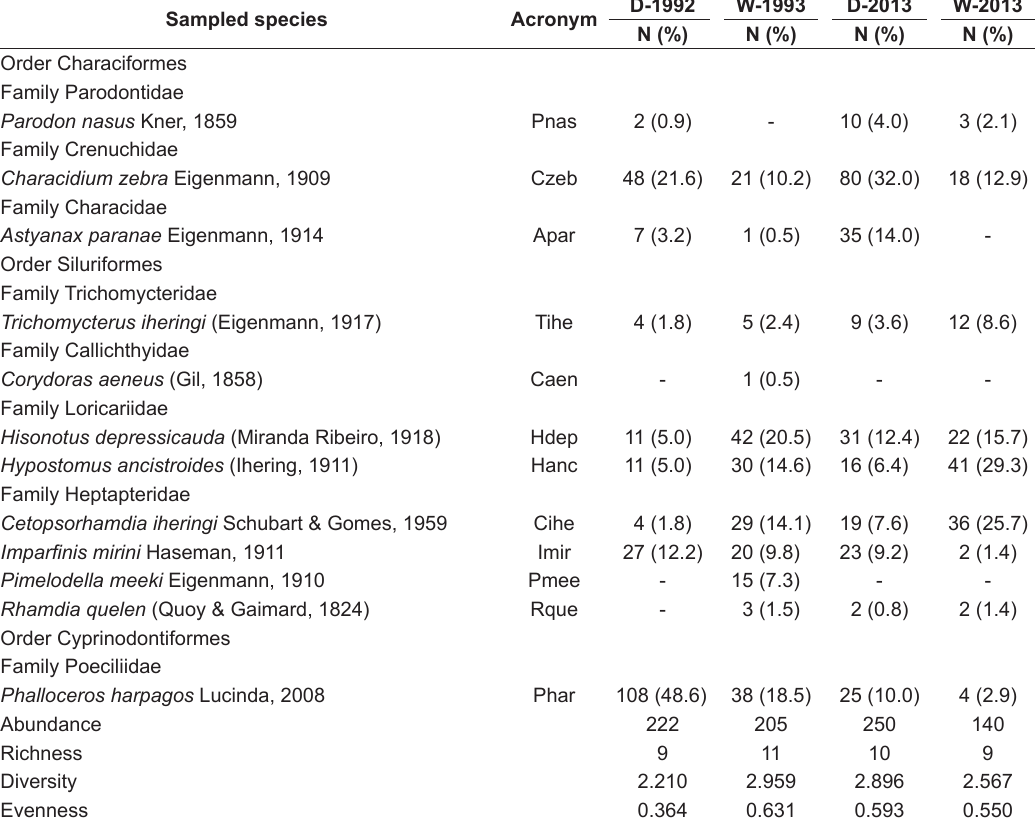
Table 3. Absolute (N) and relative (%) abundance of fish species sampled in the Capivara River, during the dry (D) and wet (W) season of 1992, 1993 and